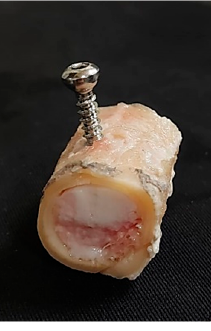
Figure 2. Bone samples for POS tests.